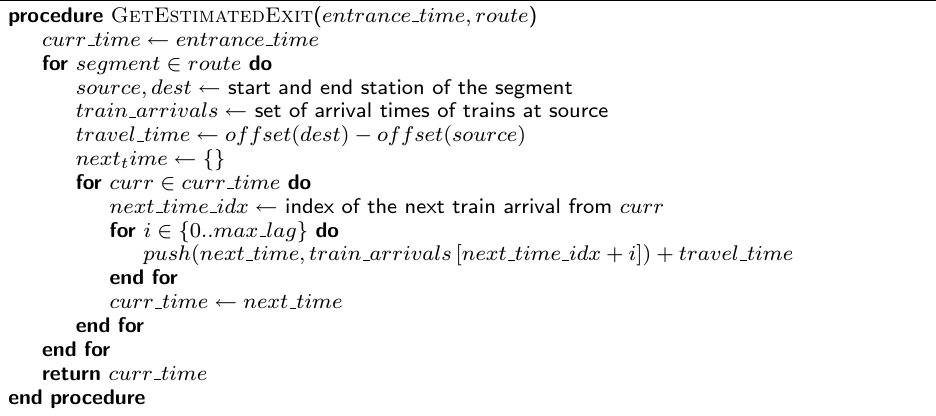
Algorithm 1 Algorithm for computing estimated exit time from a candidate